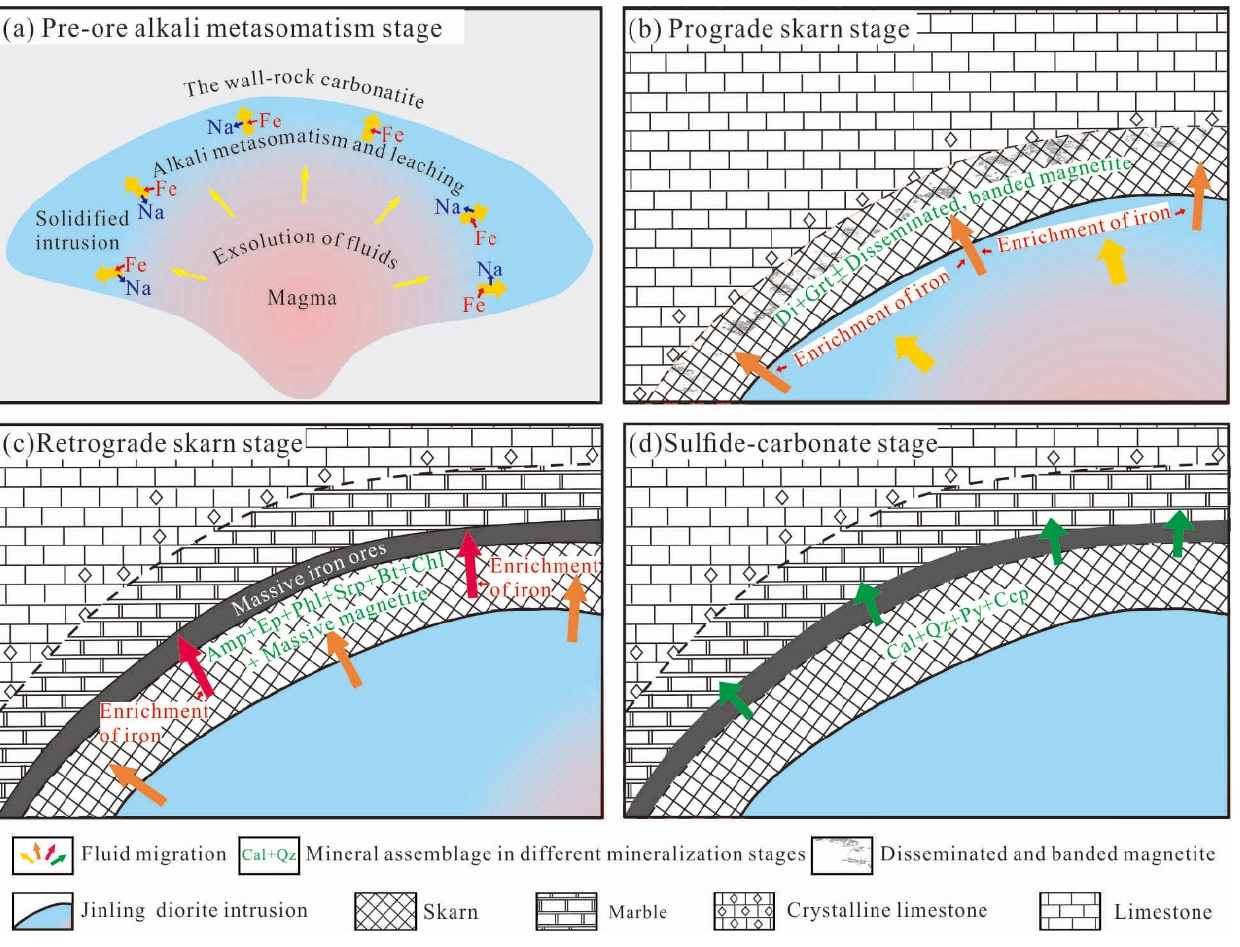
Figure 16. Sketch model of mineralizing processes of the Jinling deposit, Western Shandong Province. ( a ) Alkali metasomatism stage along with fluid exsolution. ( b ) Diopside and garnet formed due to fluid–rock interaction during the prograde skarn stage. ( c ) Amphibole, chlorite and epidote formed and the precipitation of large quantities of magnetite occurred during the retrograde skarn stage. ( d ) Carbonate, quartz and small amounts of sulfides formed during the sulfide–carbonate stage.